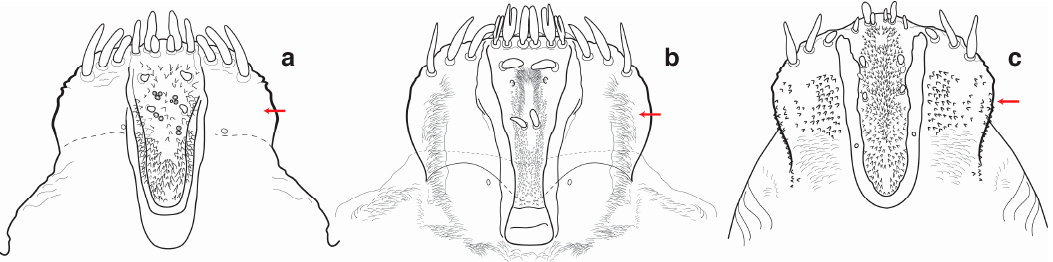
Figure 21. Epipharynx, larva: ( a ) Diocalandra ; ( b ) Metamasius ; and ( c ) Phacecorynes.